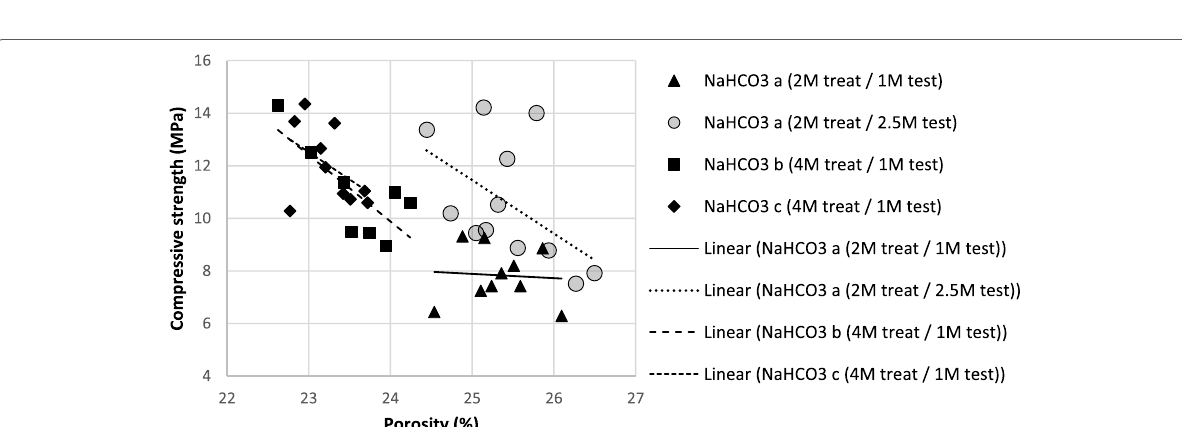
Fig. 1 Compressive strength versus porosity: water treated specimens, segregated by Batch (“X M treat” tested Y months after treatment ended) =